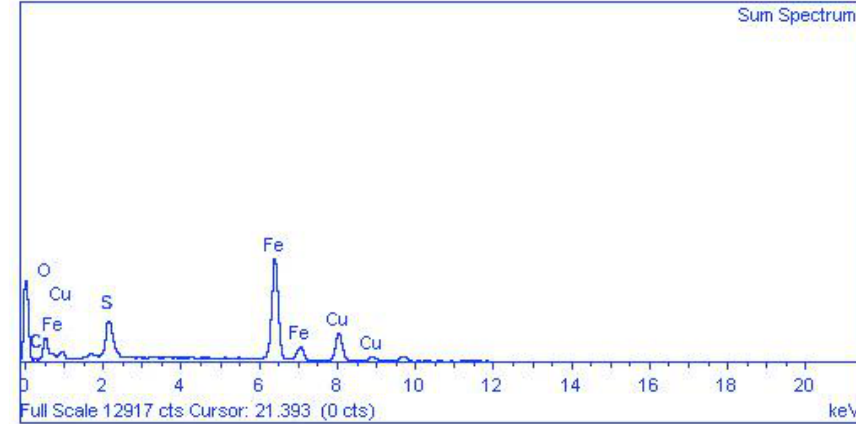
Fig. 3. EDX analysis of CuFe